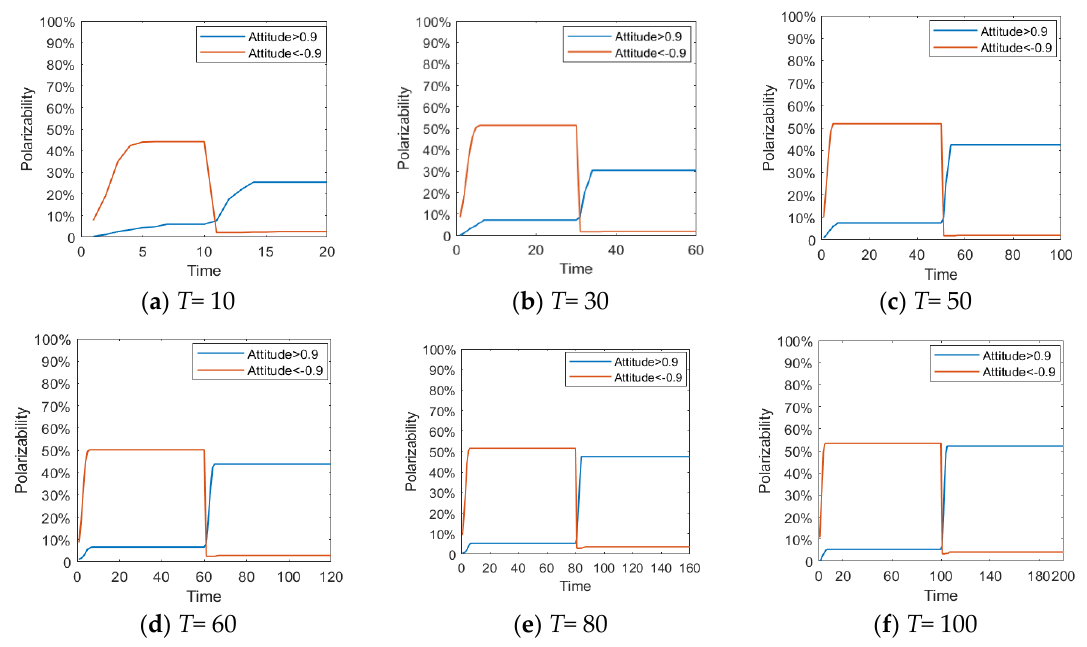
Figure 24. Curve of group attitude polarization under different interaction times. ( a ) T = 10; ( b ) T = 30; ( c ) T = 50; ( d ) T = 60; ( e ) T = 80; ( f ) T = 100.